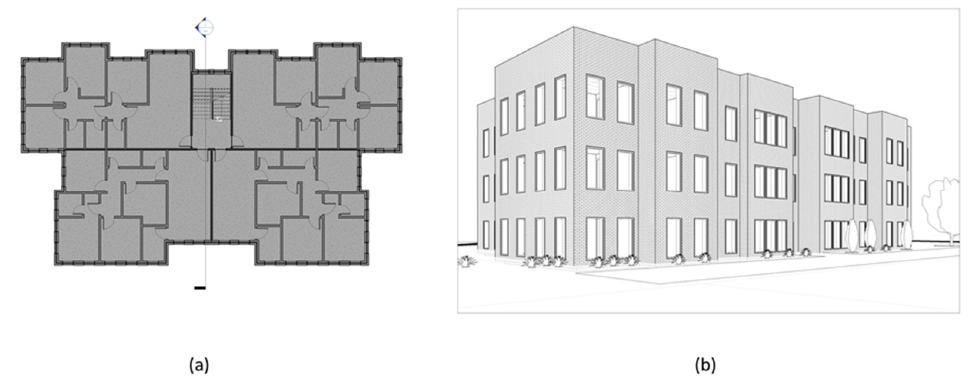
Figure 2. Building model using Building Information Modelling (BIM). The figure in ( a ) is the floor plan showing the detailed floor plan view of the modelled building and the figure in ( b ) represents the final 3D view of the complete building.